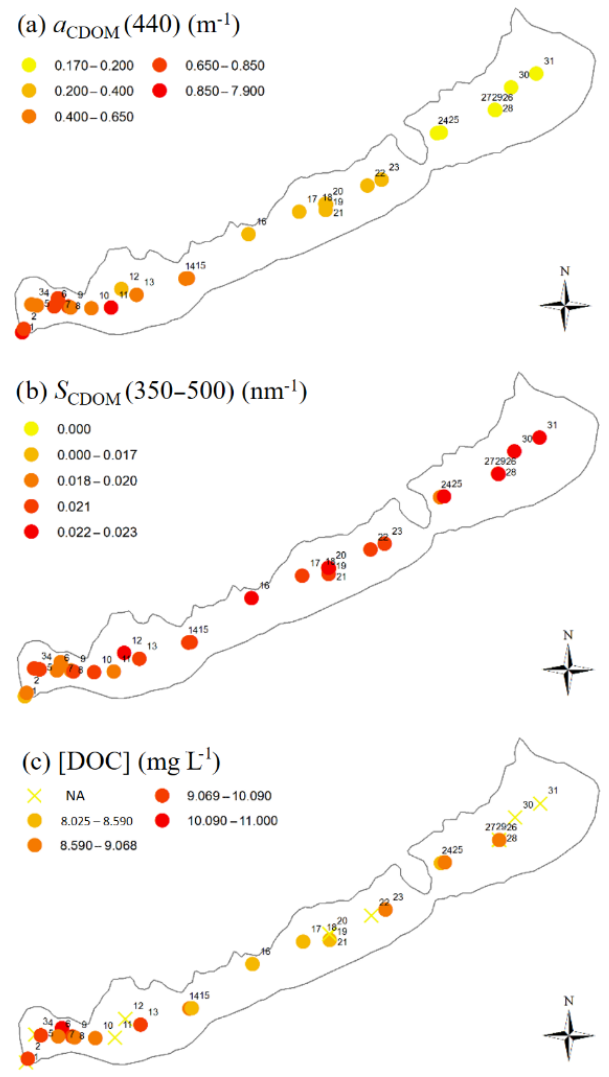
Figure 5. (a) Spatial a CDOM (440) variation in Lake Balaton per station. (b) Spatial S CDOM (350–500) variation in Lake Balaton per station. (c) Spatial DOC concentration in Lake Balaton per station. Data derived from measurements made in July